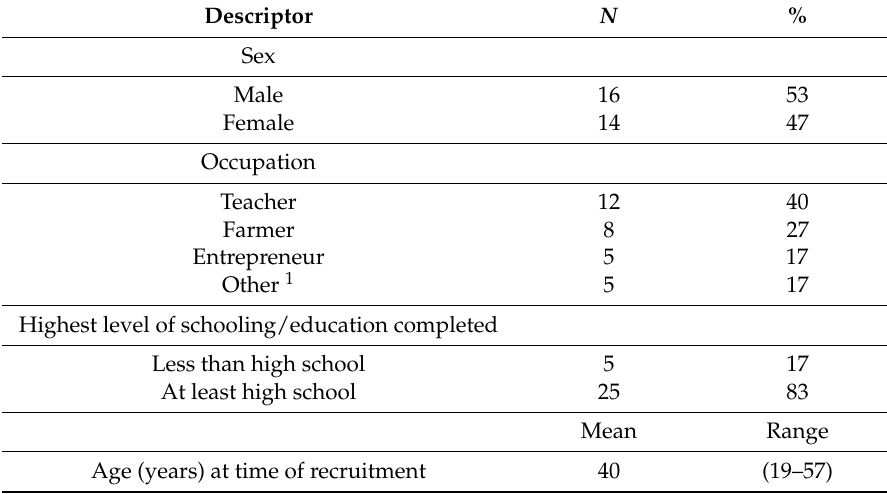
Table 1. Description of the